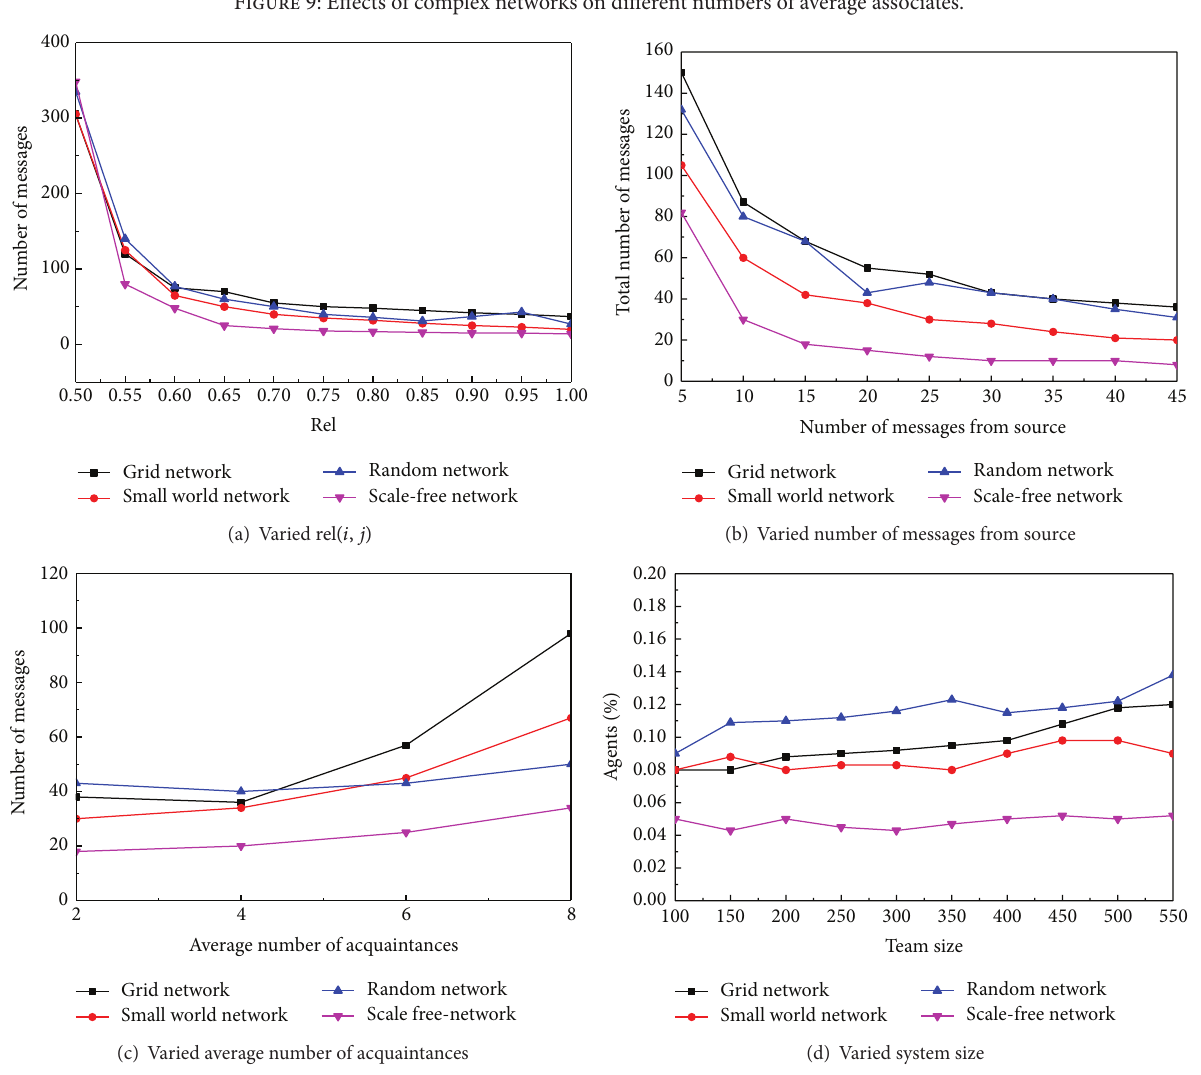
Figure 10: Communication transmission over different network